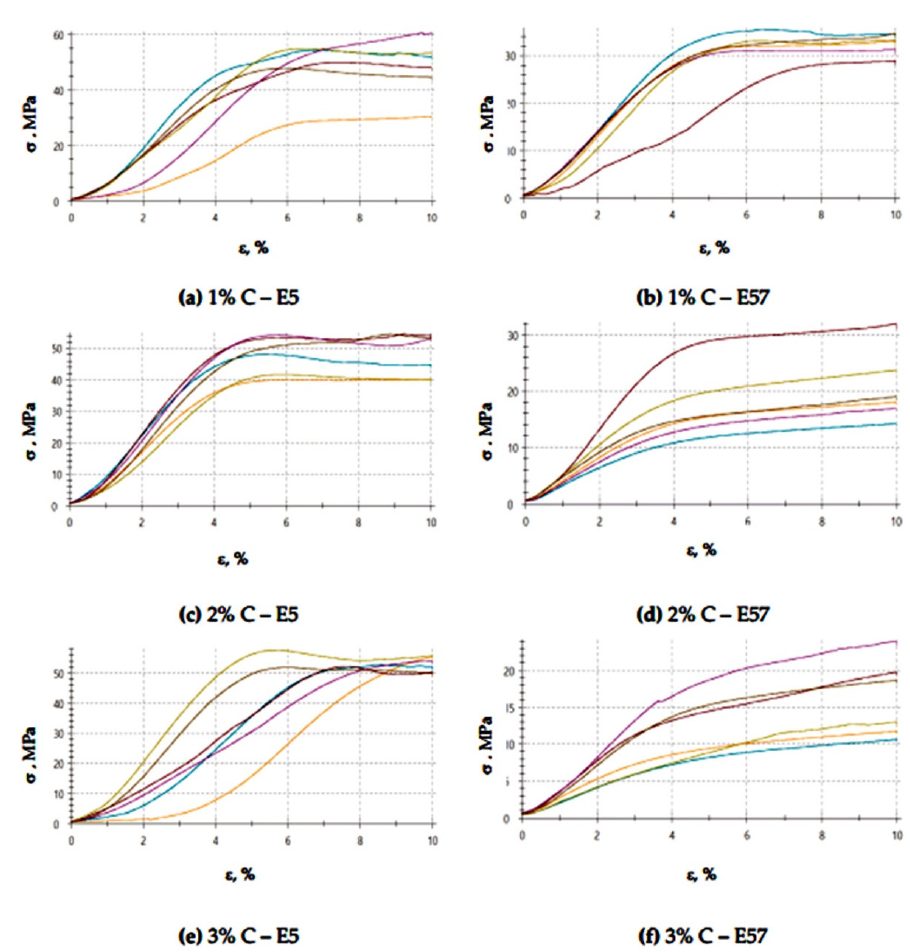
Figure 18. Stress–strain curves of the E5 / PAC / 100:80 and E57 / PAC / 100:80 epoxy specimens modified by the activated carbonate filler post-climate chamber aging: ( a ) 1% C—E5, ( b ) 1% C—E57, ( c ) 2% C—E5, ( d ) 2% C—E57, ( e ) 3% C—E5, ( f ) 3% C—E57.